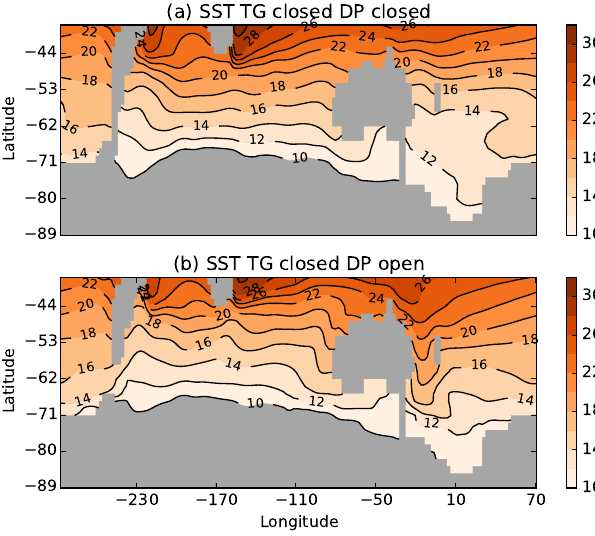
Figure 8. Sea surface temperature for (a) the Drake Passage (DP) closed and (b) the DP